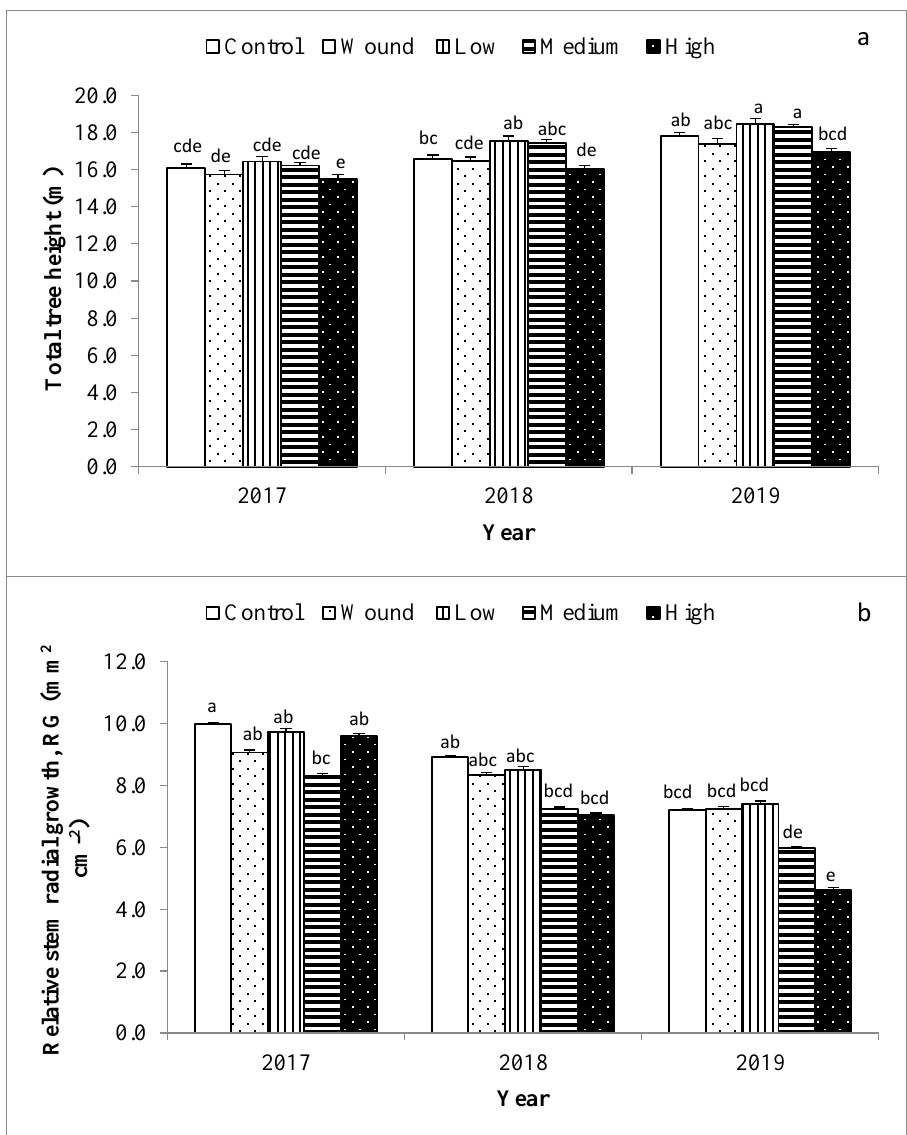
Figure 2. Mean P. taeda total height ( a ) and relative stem radial growth ( b ) 34 months following lower stem inoculation with L. terebrantis in March 2017. Means associated with different lowercase letters are significantly different at an α -level of 0.05 by the Tukey HSD test for multiple comparisons. Bars represent one standard error of the mean.